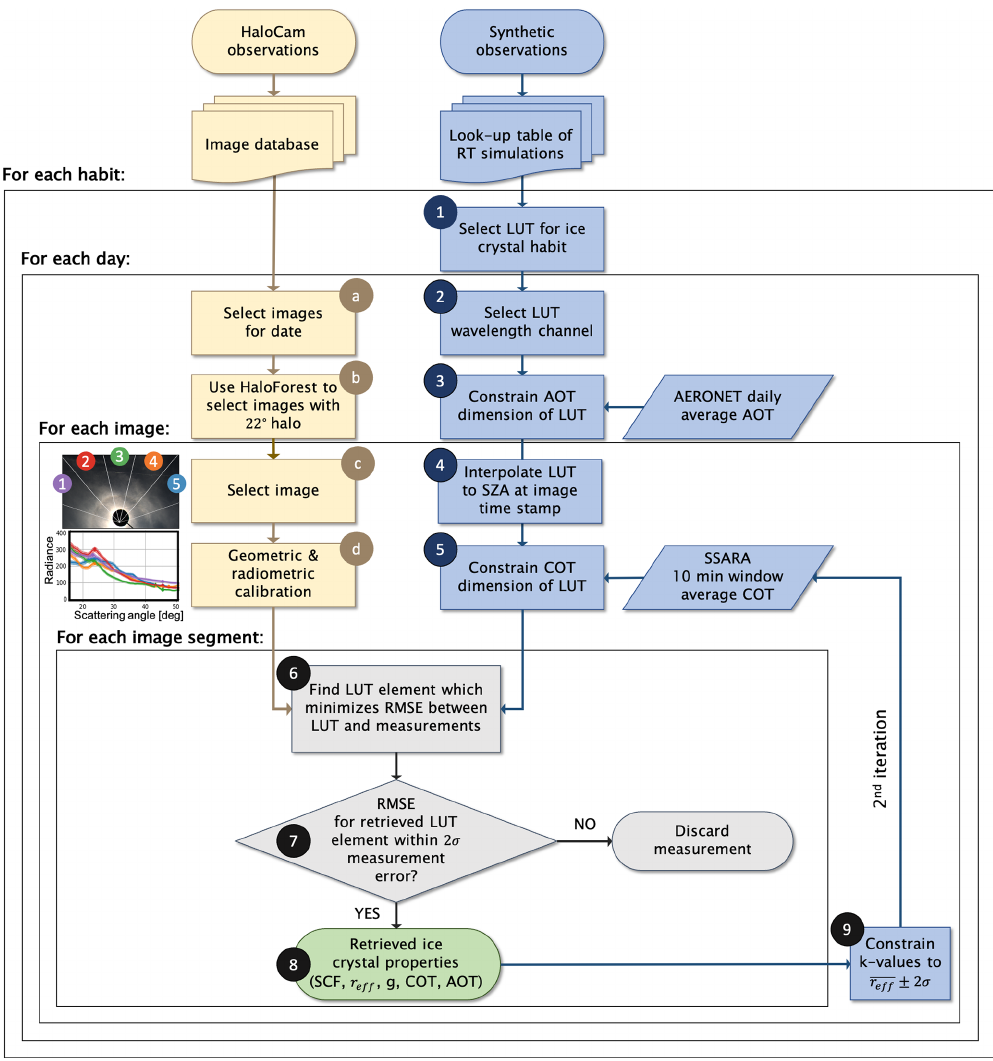
Figure 4. Flowchart visualizing the individual steps of retrieving representative ice crystal properties by finding the best match between HaloCam observations (yellow) and a LUT of radiative transfer simulations (blue).